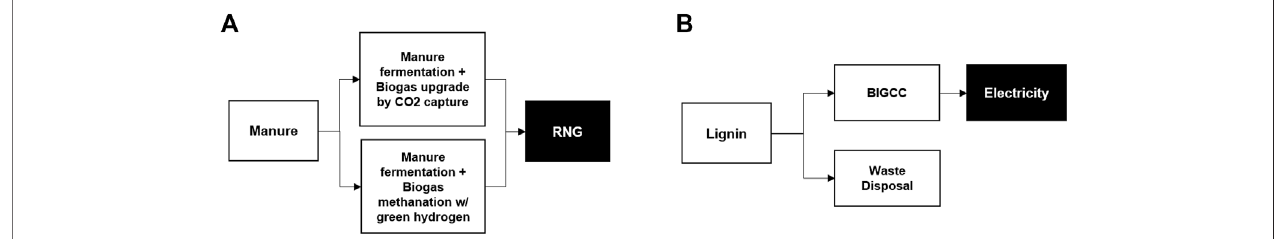
FIGURE 3 | Superstructure of alternatives for the conversion of manure (A,B) lignin into value-added products. RNG: renewable natural gas-biogas; BIGCC: biomass integrated gasi fi cation combined